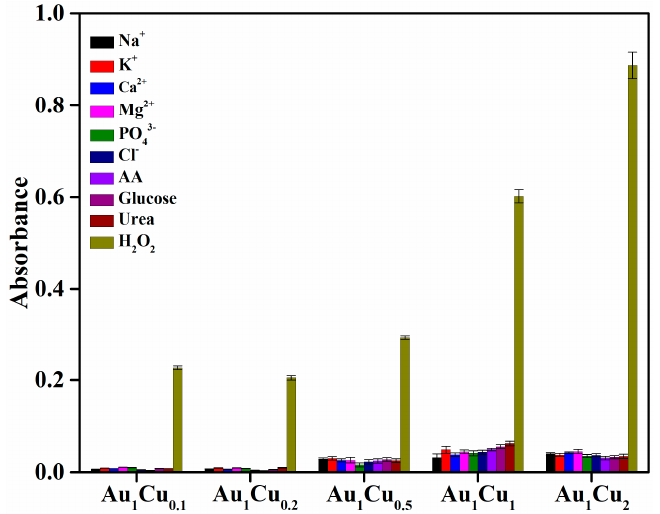
Figure 6. Selectivity analysis of H 2 O 2 detection using Au–Cu alloy nanoparticles as peroxidase mimetics. The concentration of H 2 O 2 and other substances was 10 mM.